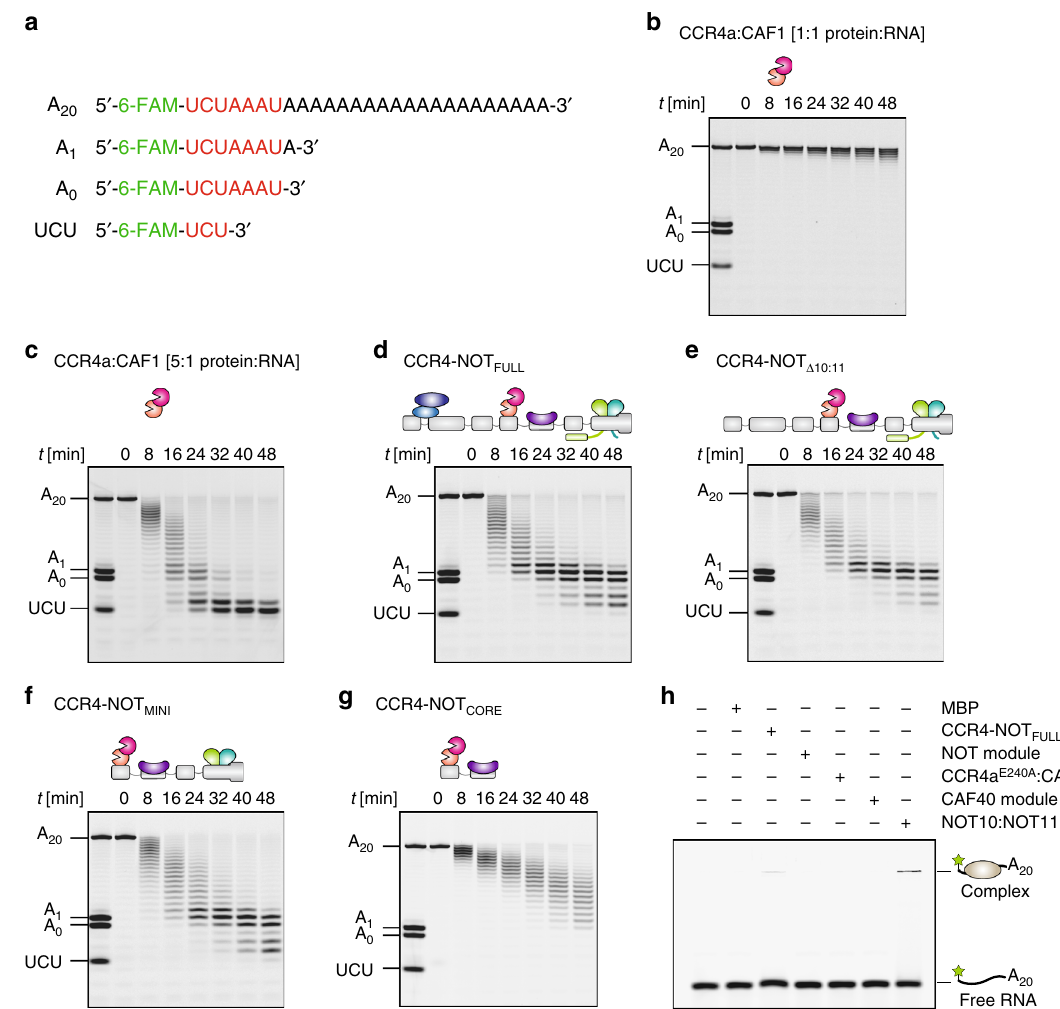
Fig. 2 The contribution of the non-enzymatic modules towards activity. a The sequence of the synthetic 7-mer-A 20 RNA substrate, which consists of a 5 ′ end 6-carboxy fl uorescein (6-FAM, green) fl uorophore, a 7-mer RNA body (red) and a tail of 20 adenosines (A 20 , black). Positional marker RNAs are also depicted. b Deadenylation assay time course experiment with the 7-mer-A 20 RNA substrate and the CCR4a:CAF1 exonuclease heterodimer in equimolar ratio (50 nM) demonstrating low catalytic activity. c Time course assay as in b , but with a 5-fold molar excess of CCR4a:CAF1 (250 nM) over 7-mer-A 20 RNA (50 nM). Under these conditions, the deadenylation reaction is rapid. d – f Deadenylation assays with 50 nM 7-mer-A 20 RNA and equimolar concentrations of the CCR4-NOT FULL ( d ), CCR4-NOT Δ 10:11 ( e ), and CCR4-NOT MINI ( f ) complexes. All three complexes produce very similar